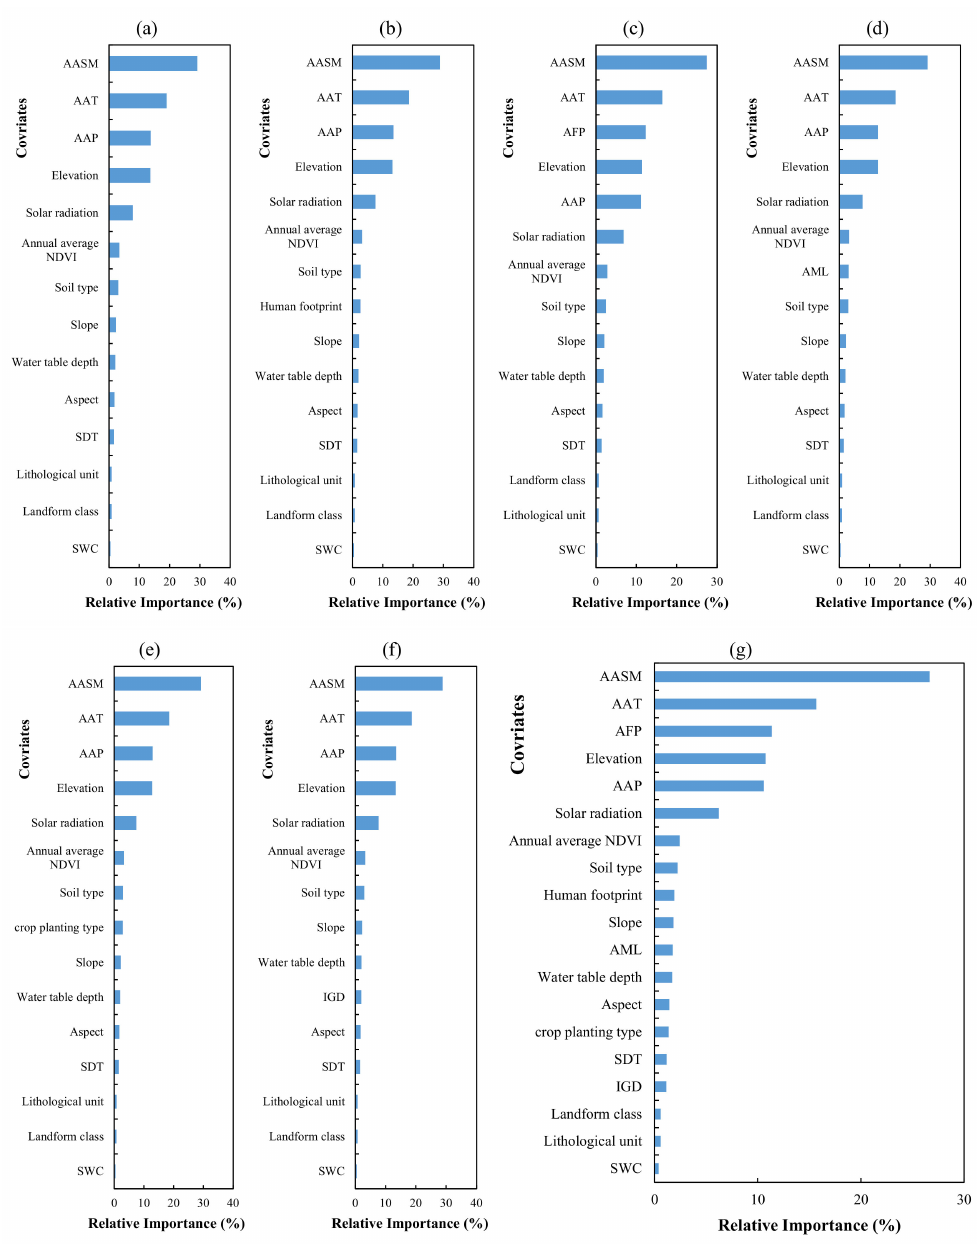
Figure 5. Relative importance of each variable for the seven models calculated by RF (SWC: surface water occurrence; SDT: sedimentary deposit thickness; AAP: annual average precipitation; AAT: annual average temperature; AFP: the amount of fertilizer application; AML: agronomic management level; IGD: irrigation guarantee degree; AASM: annual average soil moisture. ( a ), ( b ), ( c ), ( d ), ( e ), ( f ), ( g ) indicate relative importance of each variable for Model 1, 2, 3, 4, 5, 6, 7,